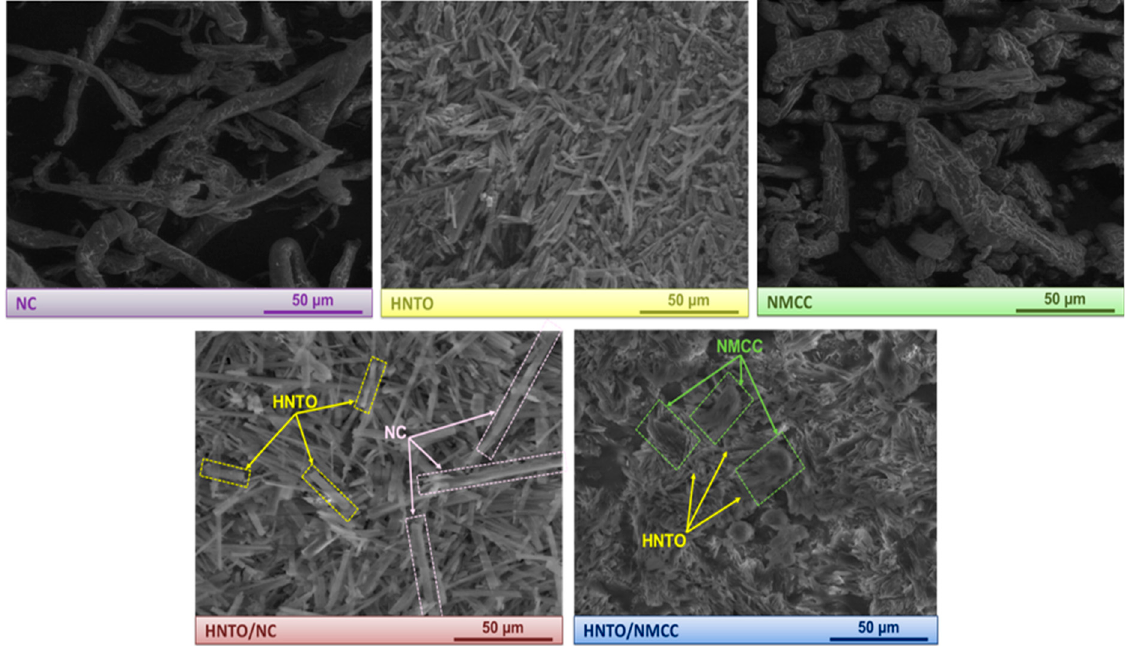
Figure 2. SEM micrographs of the elaborated energetic composites and their raw compounds.